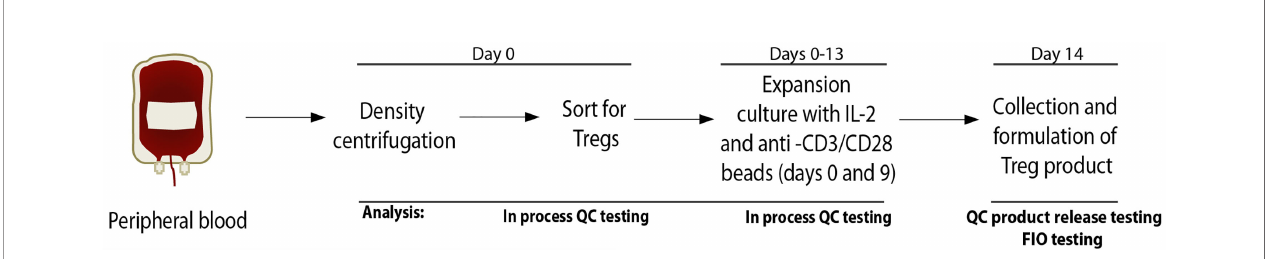
FIGURE 1 | Outline of Treg cell collection and manufacturing process. QC, quality control; FIO, for information